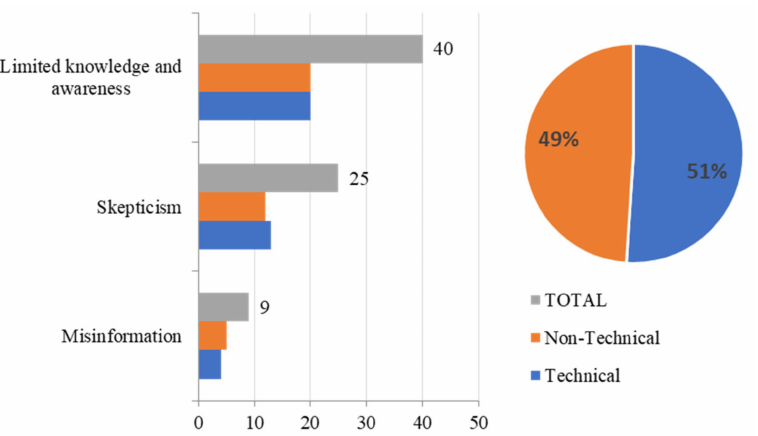
Figure 3. Knowledge and awareness barrier sub-themes with the number of participants who